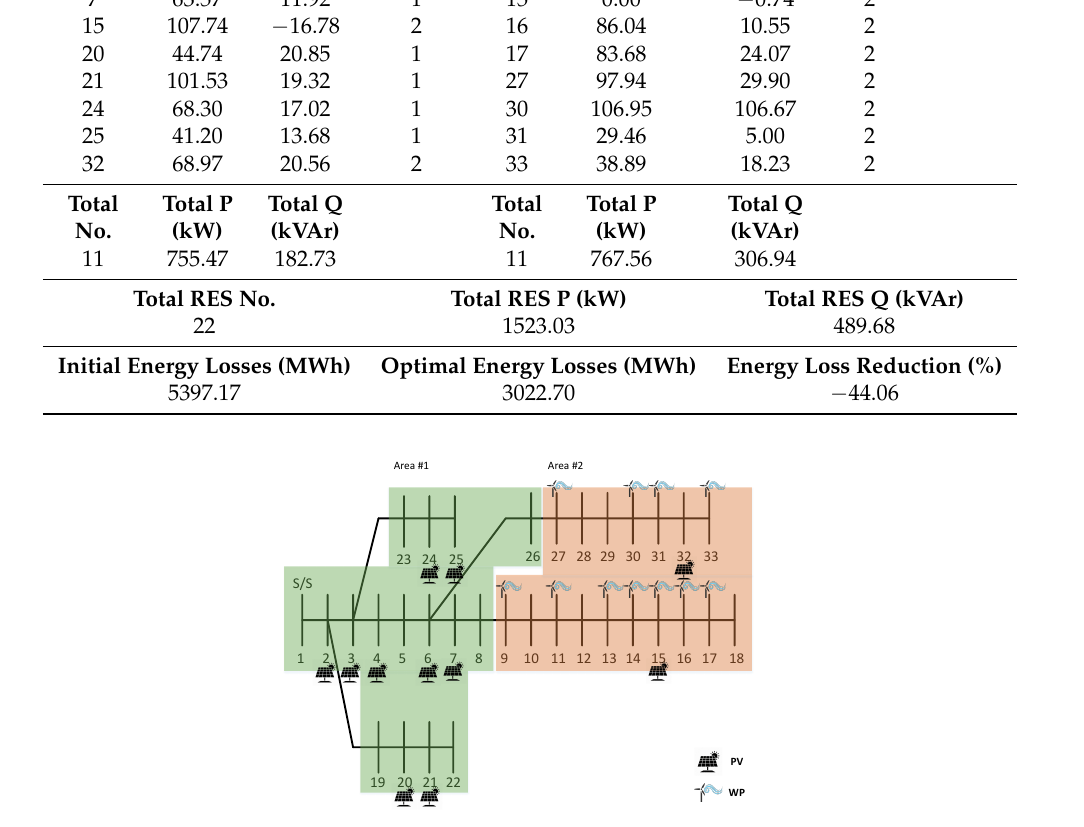
Figure 28. Snapshot—mean value—Scenario #1 solution.